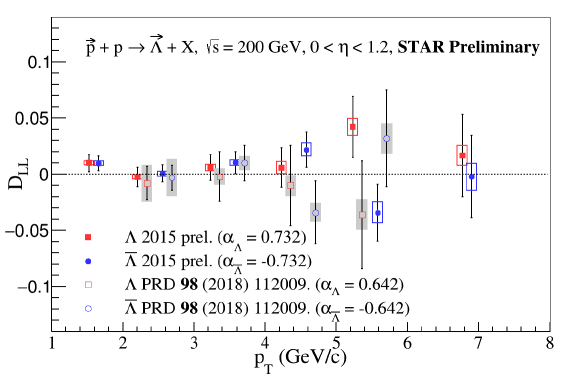
Figure 2: Preliminary results of D together with previously published results. The results for the ¯ Λ and the previously published results have been shifted slightly to larger p